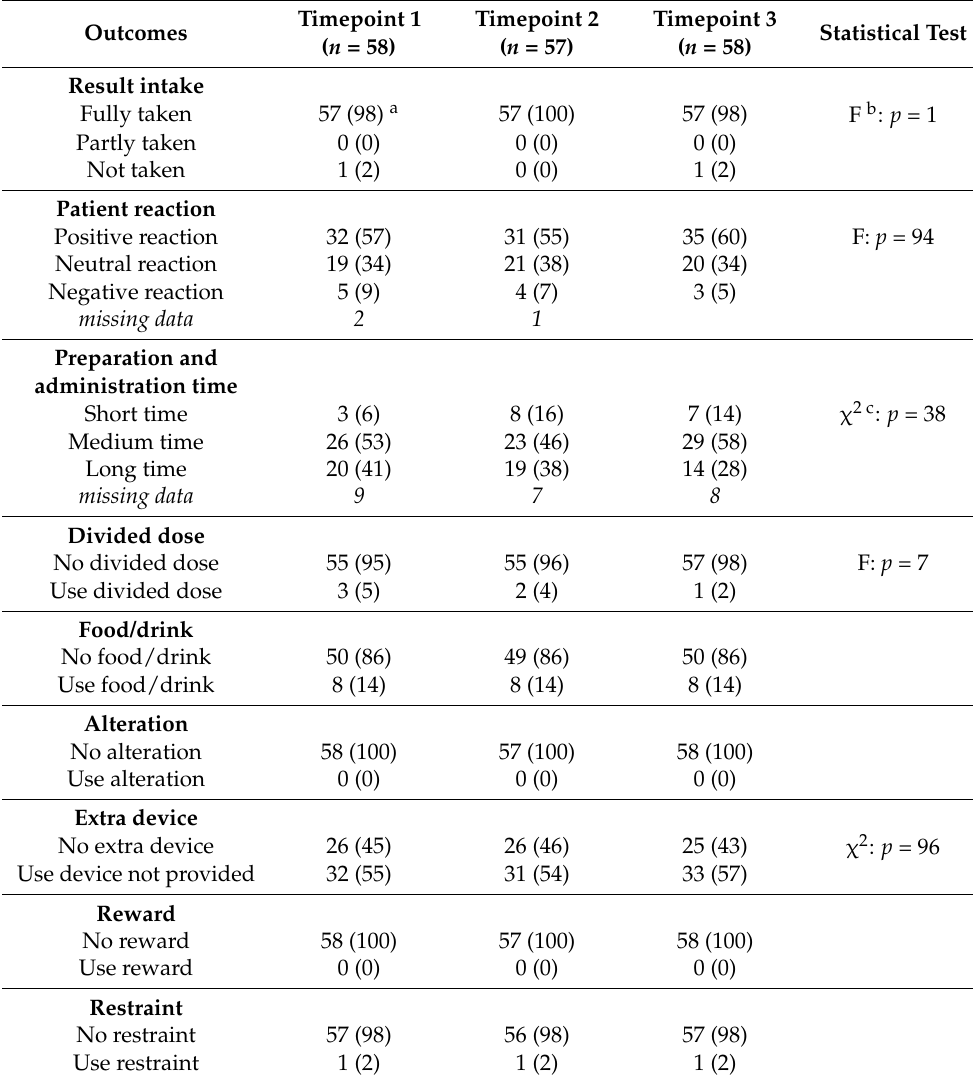
Table 1. Observer-reported outcomes over